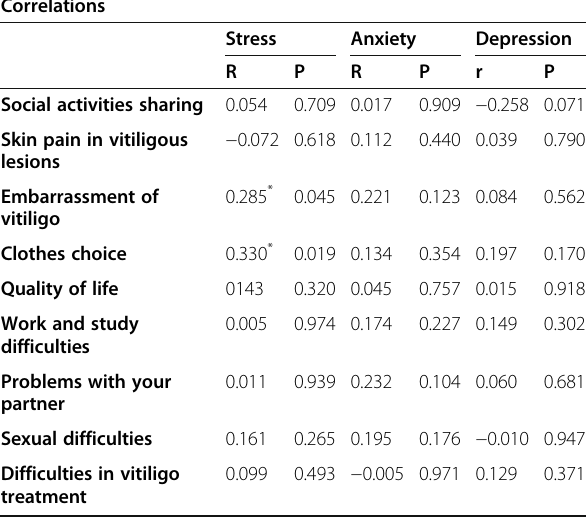
Table 4 Correlation between patient ’ s stress, anxiety, Table 5 Correlation between patient ’ s stress, anxiety, depression, and both demographic and clinical data of patients depression, and quality of life Stress Anxiety